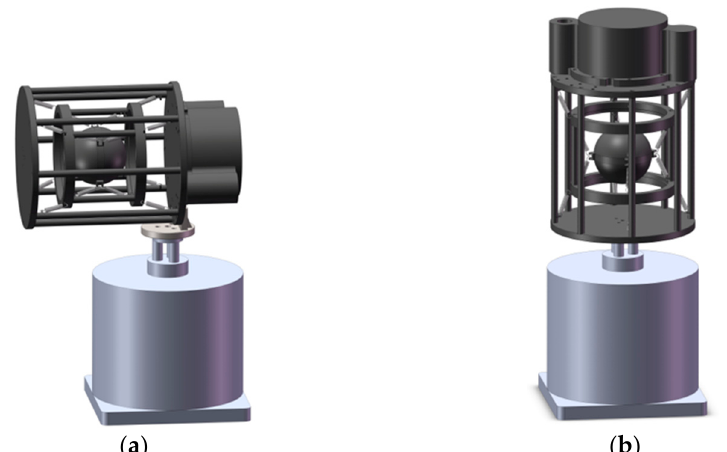
Figure 13. The installation diagram of the suspension systems (take TSSS for instance): ( a ) for testing the acceleration transmission along X and Y direction; ( b ) for testing the acceleration transmission along the Z direction.